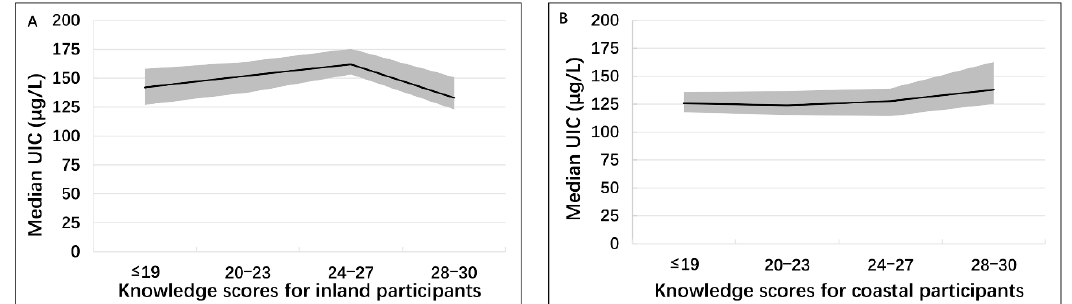
Figure 2. Urinary iodine status distributed by the total knowledge scores among participants in the inland region ( A ) and the coastal region ( B ). Black lines show the median urinary iodine concentration (UIC). Light gray shadows show the corresponding 95% confidence interval (CI) of the median UIC.